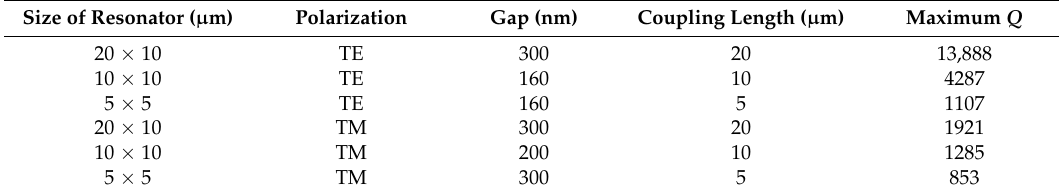
Table 1. Optimum parameters to obtain the highest Q value.